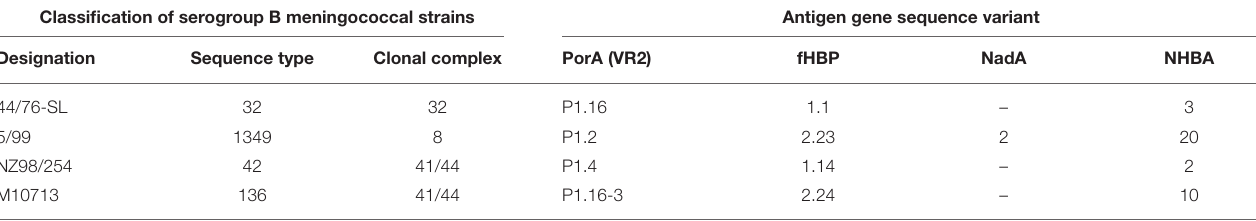
TABLE 1 | MenB indicator strains used to assess bactericidal activity induced by immunization with 4CMenB. Classification of serogroup B meningococcal